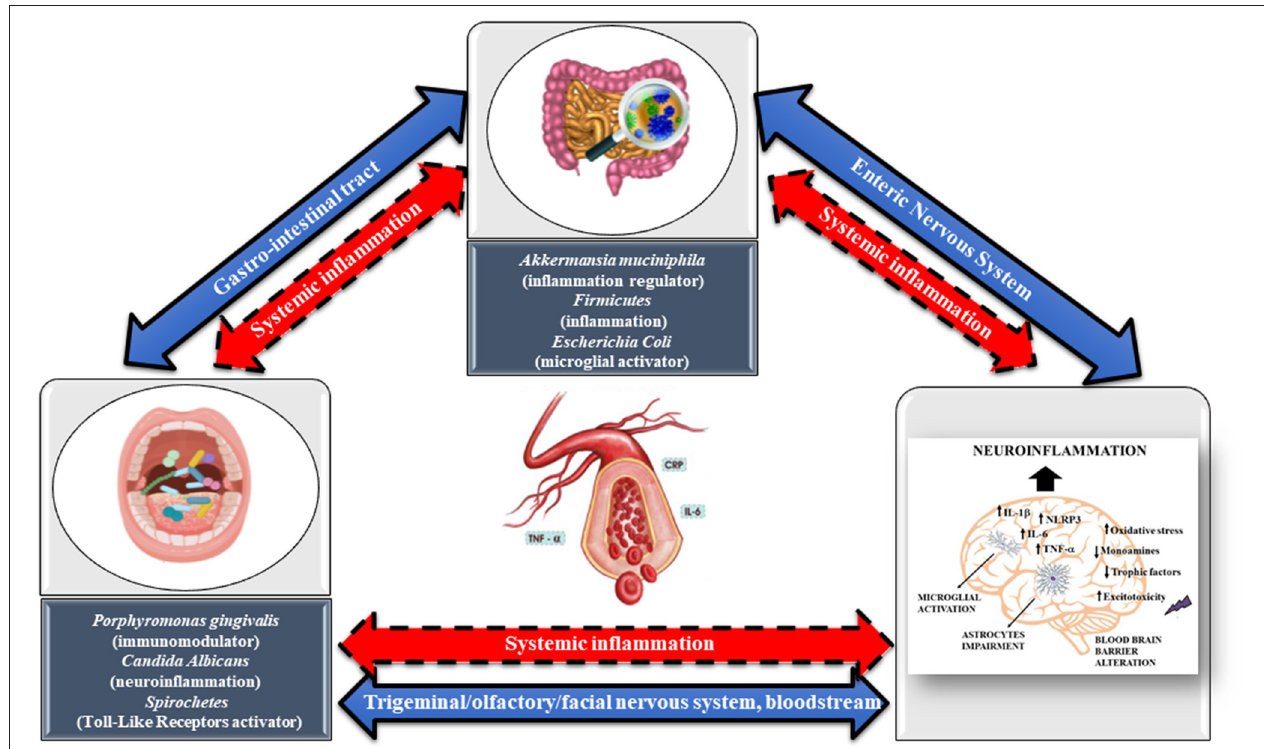
FIGURE 1 | The direct mechanisms through which oral bacterial species and their products can impact the brain are represented by trigeminal/olfactory/facial nervous system and circulating blood (blue arrow, continuous line), whereas those indirect are through the involvement of GM dysbiosis and systemic inflammation (red arrow, dashed line, bidirectional). Likely, the direct mechanisms through with the GM and its products can affect the brain are the enteric nervous system (blue arrow, continuous line, bidirectional), whereas those indirect are through the mediation of systemic inflammation (red arrow, dashed line, bidirectional). Both direct and indirect effects coming from oral microbiota and GM can contribute to microglia-mediated neuroinflammation, resulting in related pathologies such as major depressive disorder. Neuroinflammation is mainly mediated by microglia, whereas perivascular myeloid cells and astrocytes play an auxiliary role. The activation of microglia promotes the release of several proinflammatory cytokines, including interleukin-IL-1 β , IL-6, tumor necrosis factor (TNF)- α , chemokines, inflammasome NLRP3, and reactive oxidative species (ROS) (oxidative stress). Continuous and progressive inflammation can lead to the accumulation of many microglia and astrocytes at the site of inflammation, and the excessive release of pro-inflammatory cytokines will further exacerbate neuroinflammation and provoke synaptic toxicity and neuronal death. Reduction in monoamines, trophic factors, and excitotoxicity are also typical hallmarks of MDD.